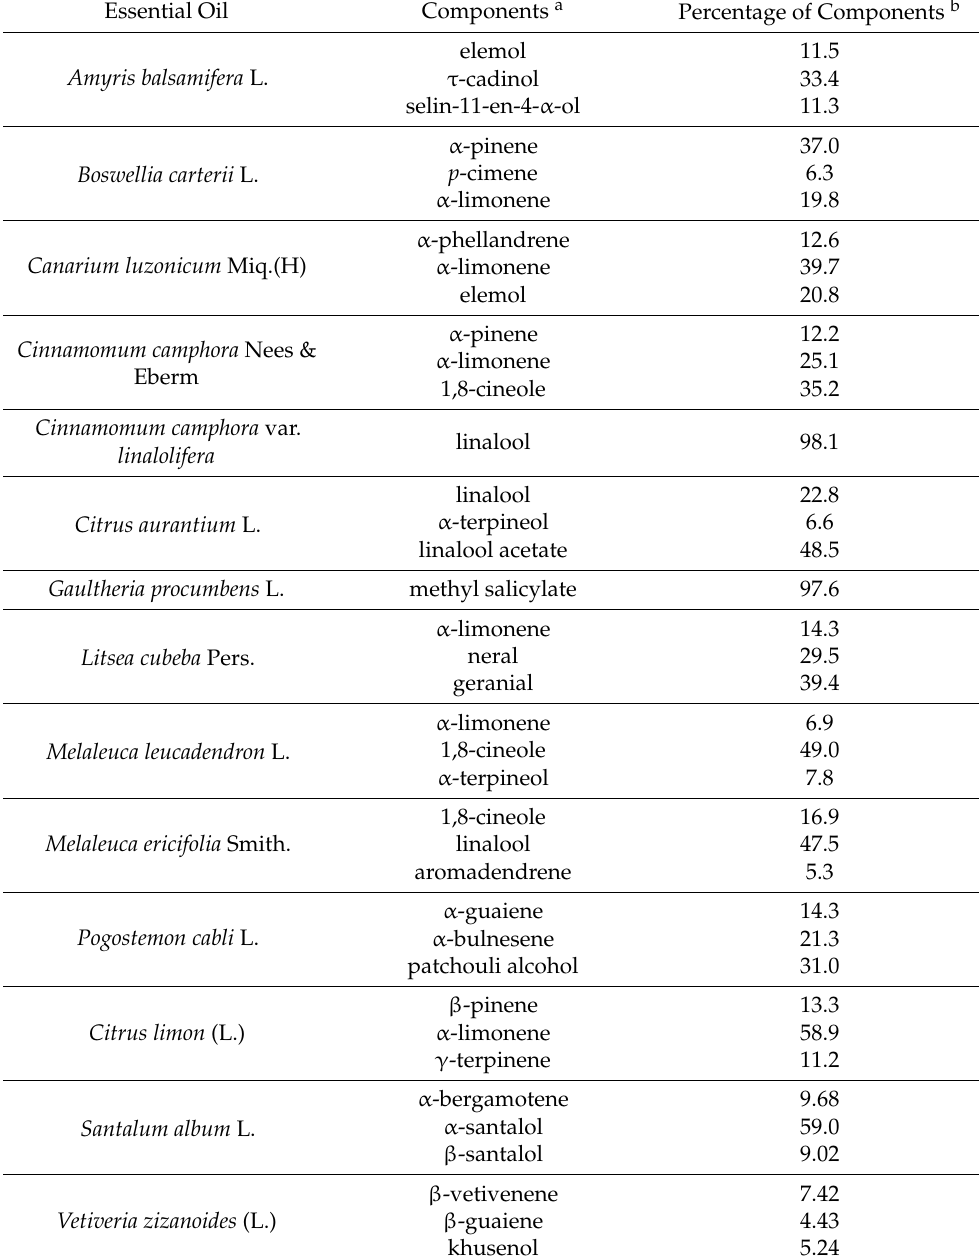
Table 1. Chemical composition of essential oils (%)